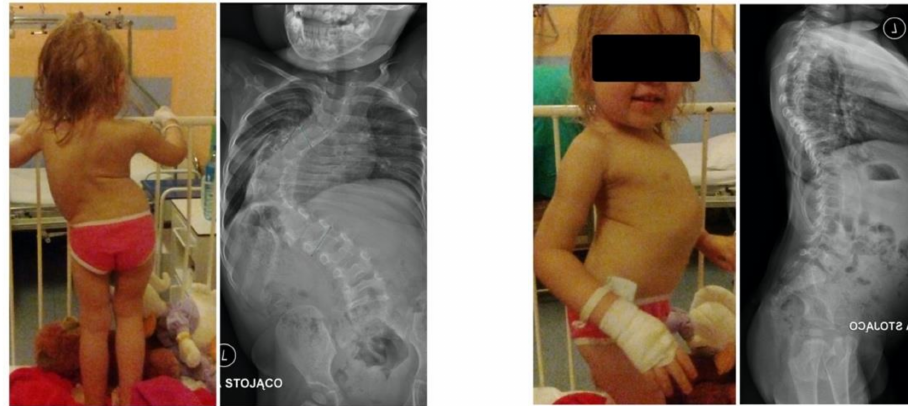
Figure 3. X-rays and clinical preoperative images.